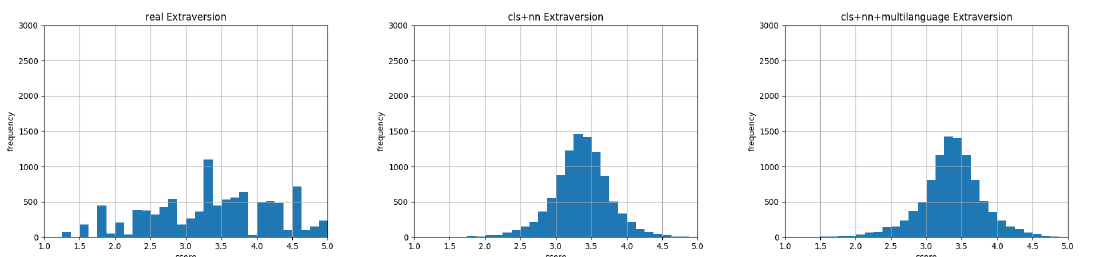
Figure 12. Conscientiousness: Histograms representing data distribution of gold standard on the left, our English model result in the middle, and our multilingual model result on the right.